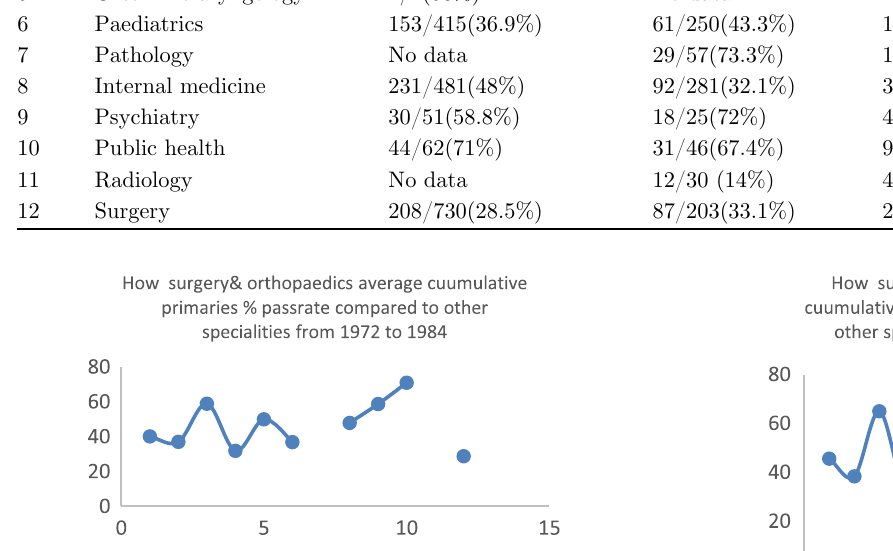
Fig. 5. How surgery & orthopaedics average cuumulative primaries % passrate compared to other specialities from 1972 to 1984.